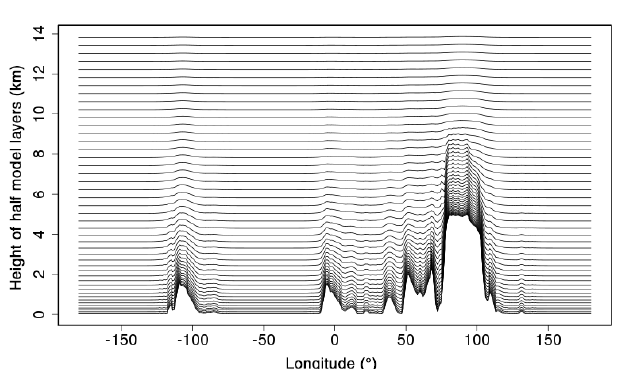
Figure 1. Height of the lowest 46 ICON model layers at 33 ◦ N in the configuration with 90 total model